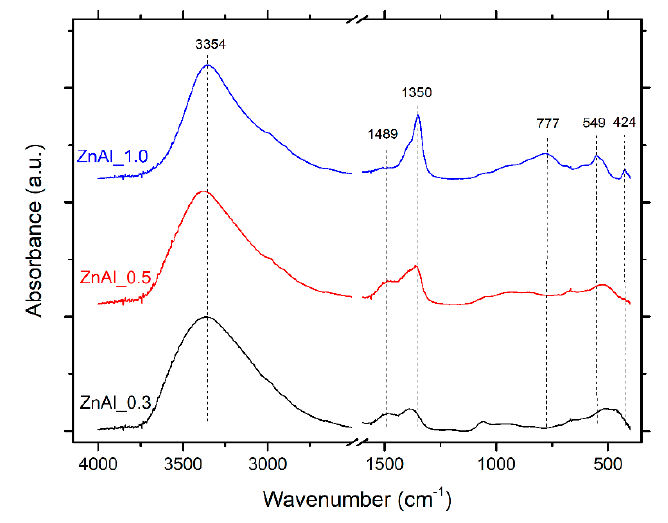
Figure 3. FT-IR spectra of ZnAl-LDHs_X samples with different Zn/Al molar ratio.